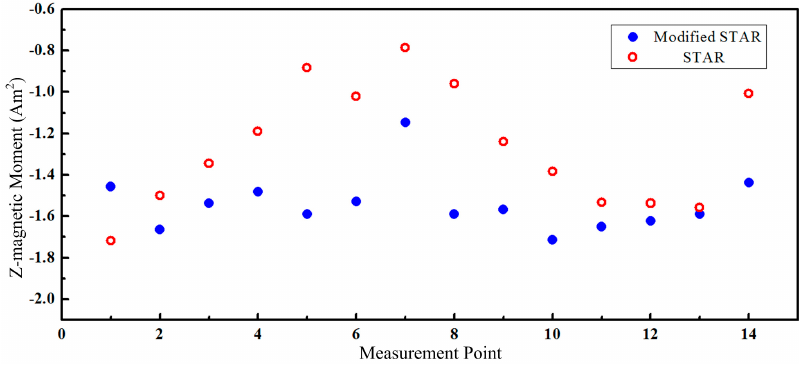
Table 2. The RMS of Localization Errors.